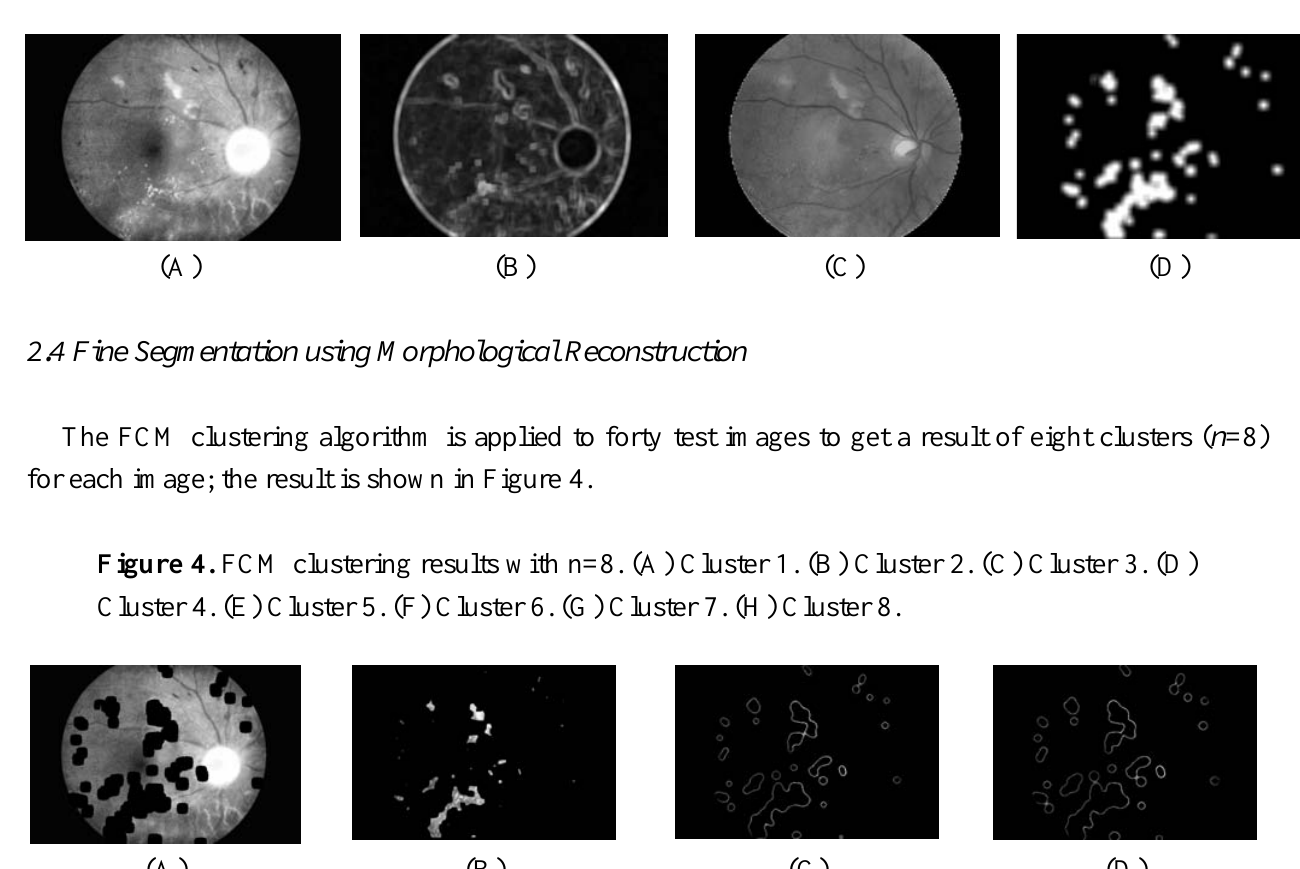
Figure 3. Input features for FCM clustering of image1. (A) Intensity image after pre- processing. (B) Standard deviation of intensity image. (C) Hue image. (D) Image of edge pixels.